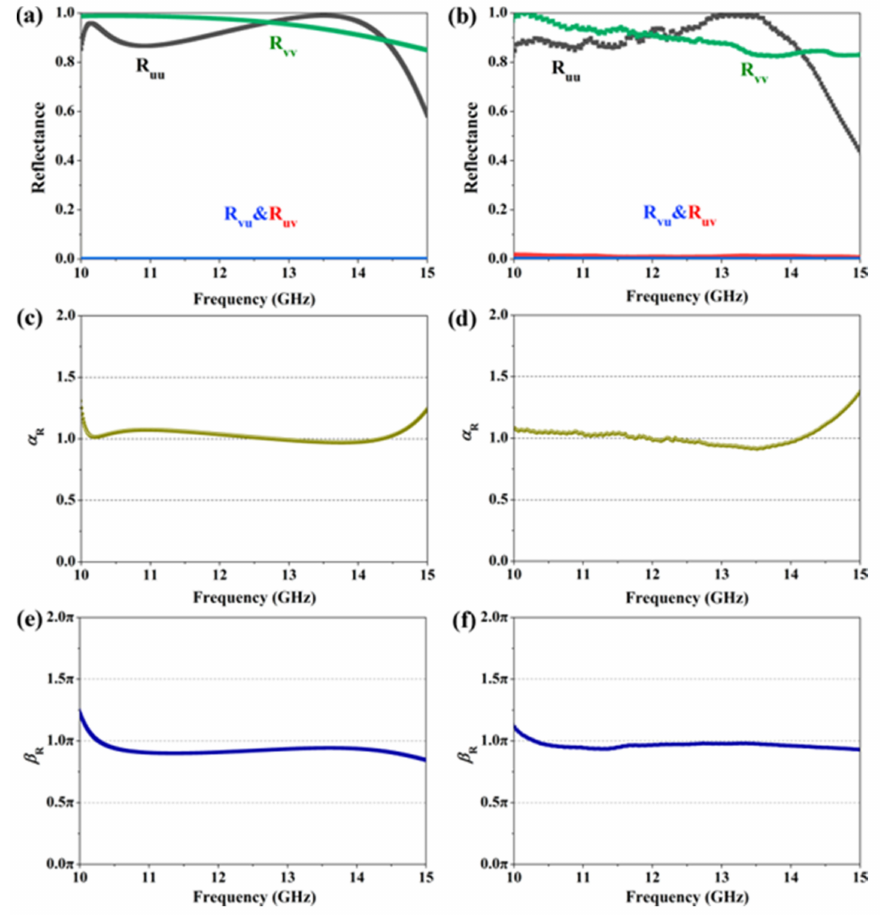
Figure 4. Numerical (left column) and experimental (right column) results of the proposed metamaterial under u - and v -polarization incidence in the reflective frequency range. ( a , b ) Reflectance, ( c , d ) amplitude ratio α R , ( e , f ) phase difference β R between u - and v